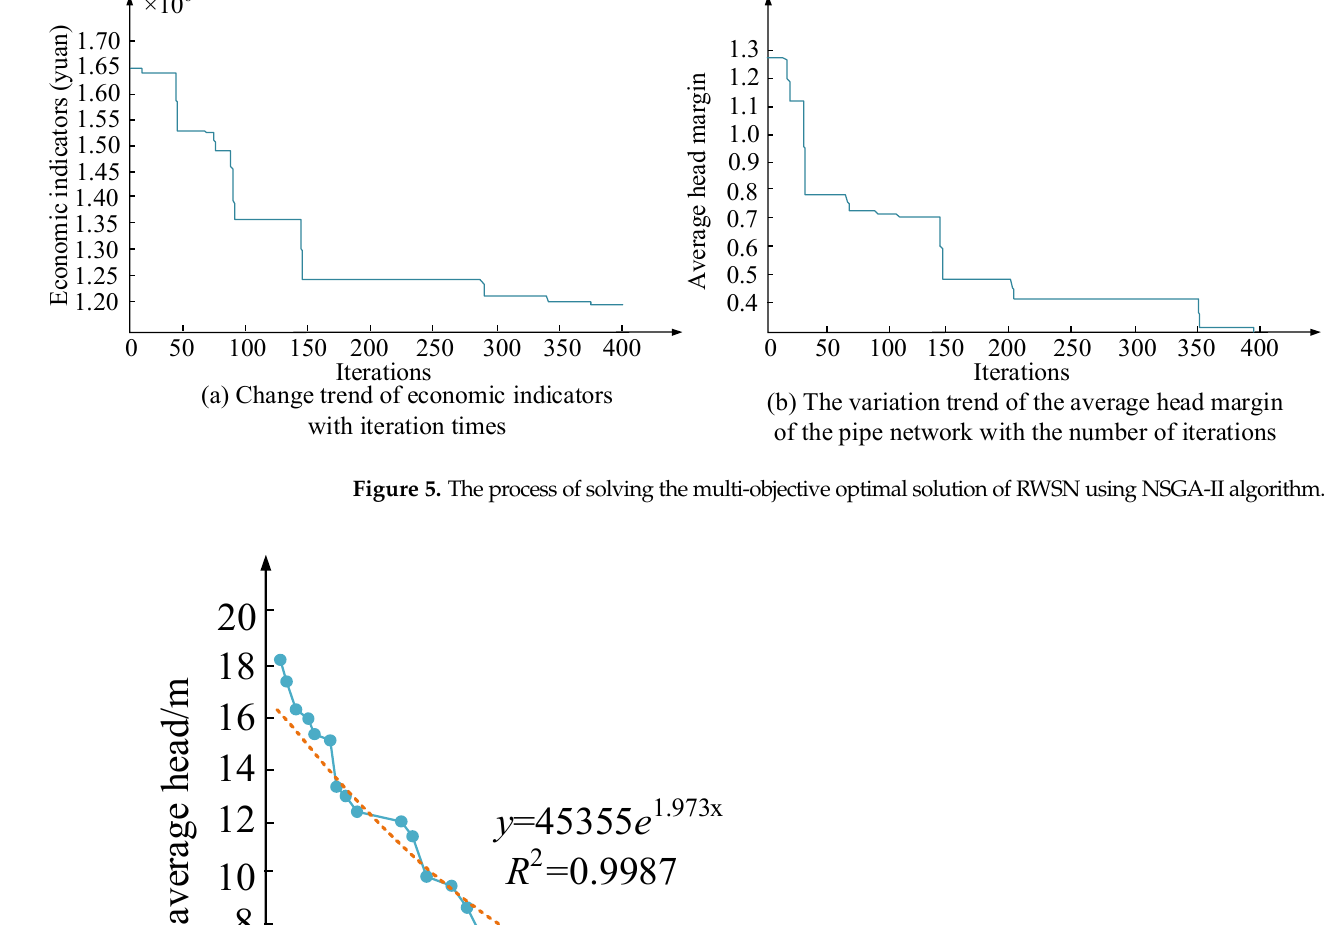
Figure 5. The process of solving the multi-objective optimal solution of RWSN using NSGA-II algo- rithm.